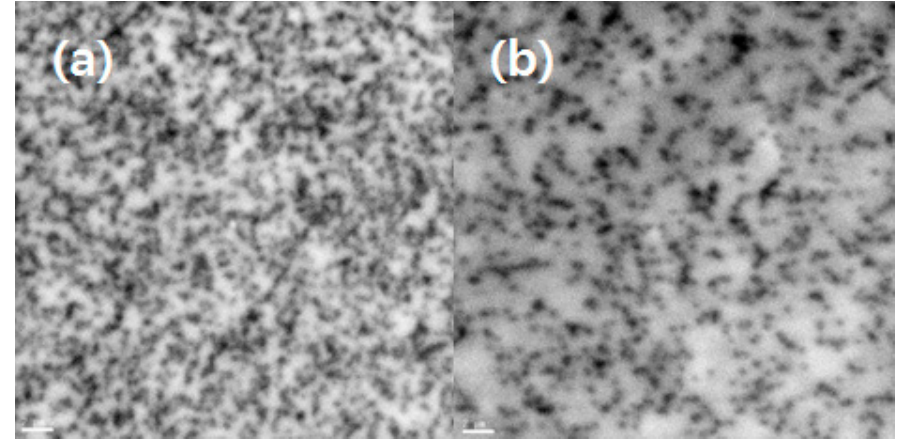
Figure A1. Dislocation densities of reference LED (( a ) ~4 × 10 8 /cm 2 ) and SiO 2 NP LED (( b ) ~1 × 10 8 /cm 2 ).